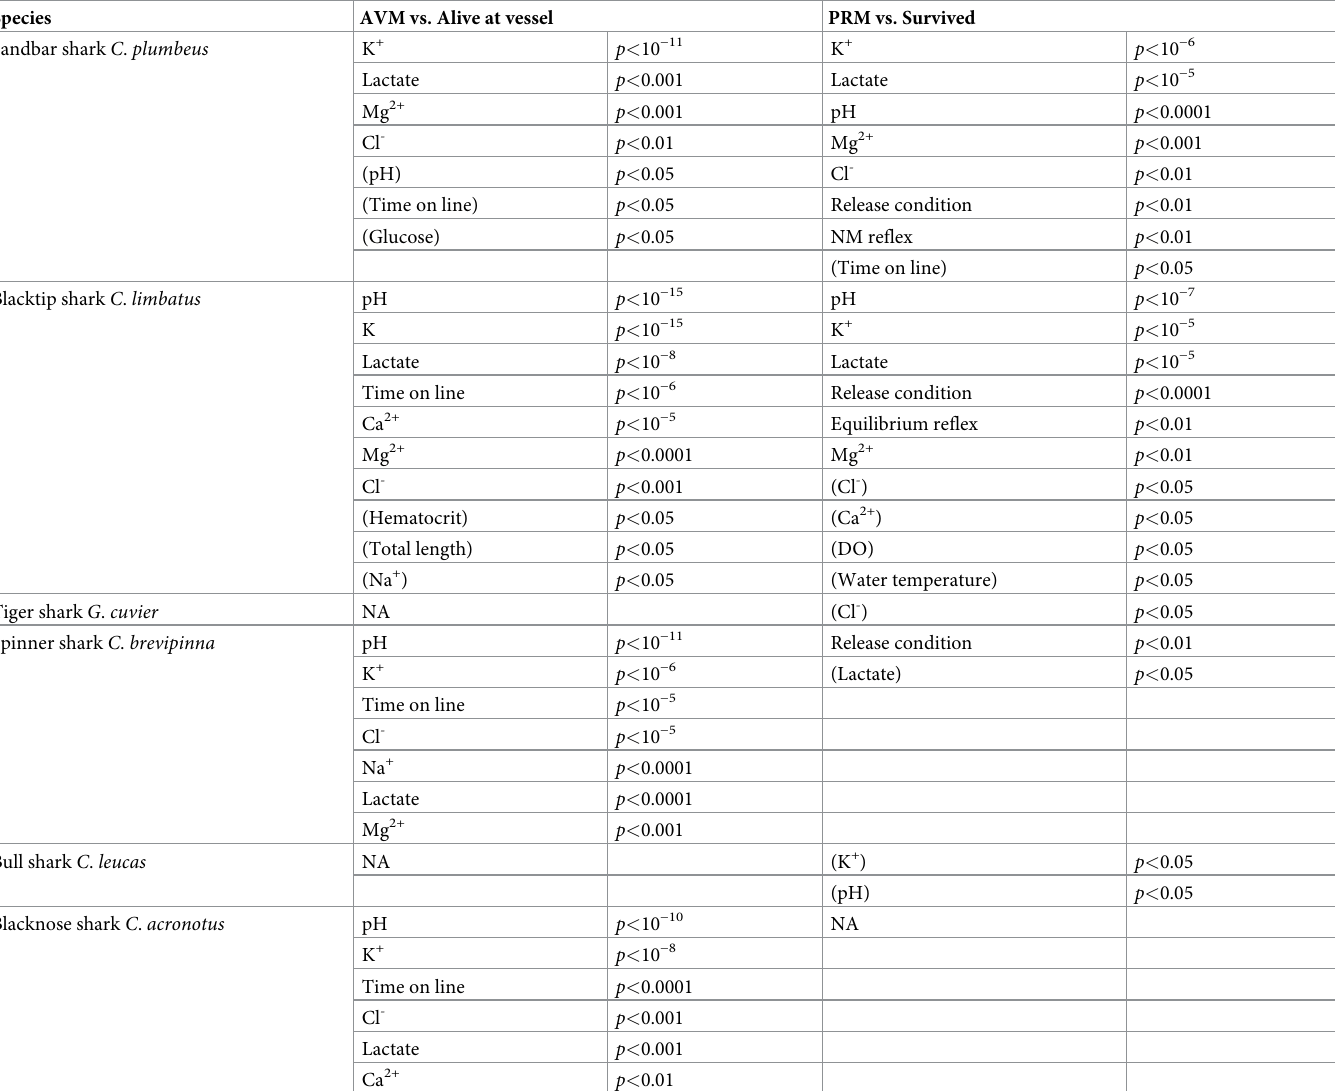
Table 3. Comparisons of at-vessel metrics between individuals alive and dead at capture, and individuals that survived or died post-release.